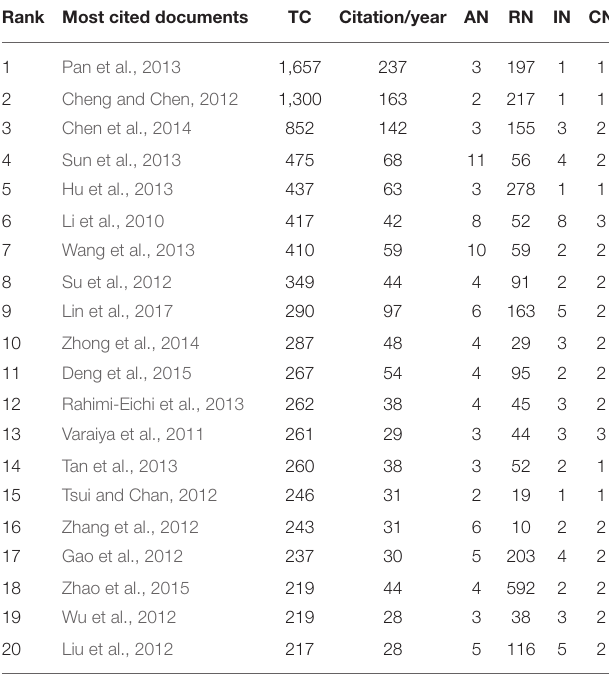
TABLE 4 | The top 20 most cited papers on SG by Chinese